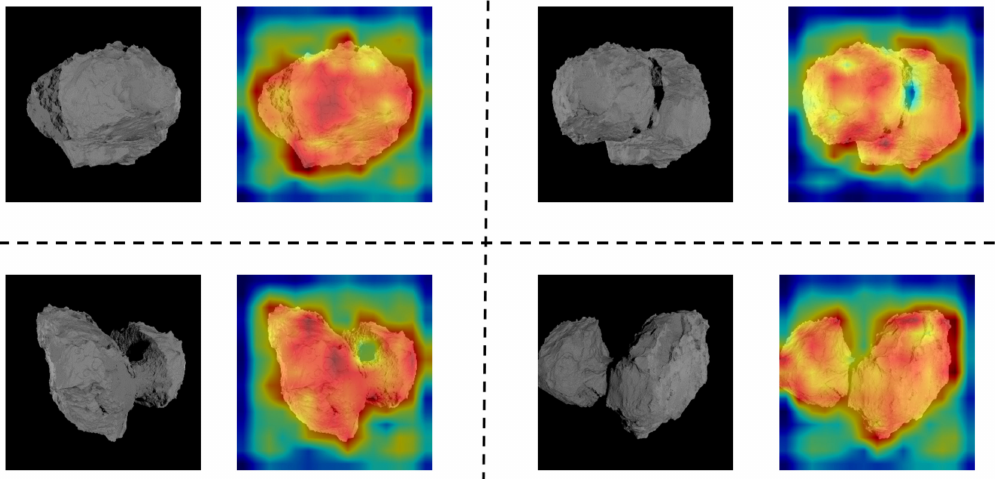
Figure 5. Raw data ( left ) and Grad-CAM visualizations ( right ) of the attention module on four different pairs of images taken from the Virtual SCB Dataset. Red regions correspond to high contributions for scale estimation, while blue corresponds to low